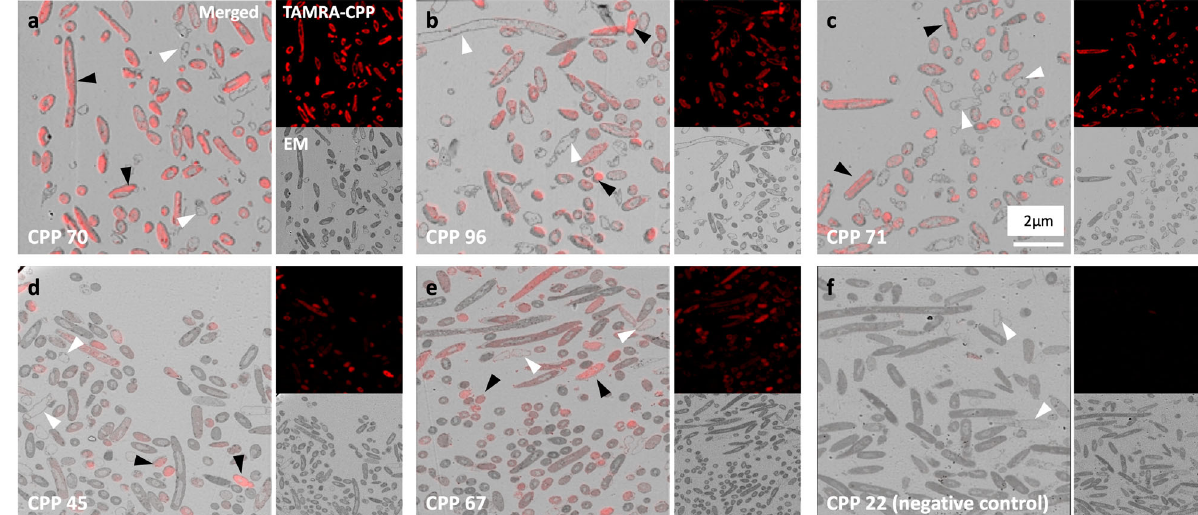
Fig. 4 Electromicroscopic pictures of E. coli cells treated with the top fi ve highly ef fi cient CPPs. Each image set shows a fl uorescence image (TAMRA- labeled CPP, top right), an electron microscope image (EM, bottom right), and a merged CLEM image. a – e CPPs that were ef fi cient in penetration. f CPP 22 was inef fi cient in penetration and was selected as a negative control. Black arrowheads indicate the bacteria in which the cytoplasm was intact and TAMRA-labeled CPPs emitted a red color. White arrowheads indicate bacteria in which the cytoplasm was removed during sectioning and that therefore lacked